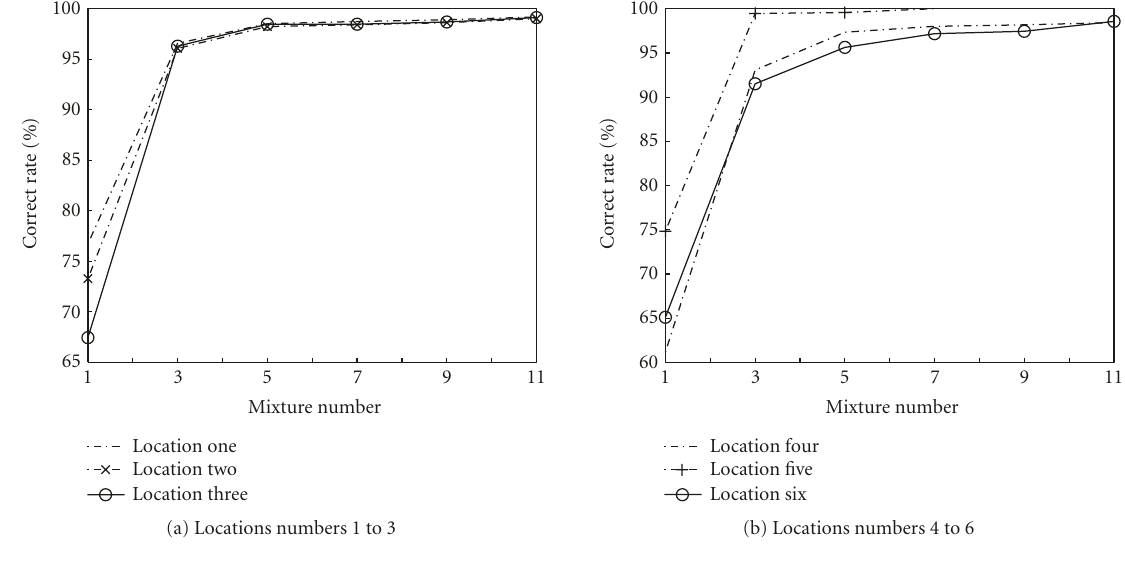
Figure 6: Average correct rates versus the mixture numbers. Table 4: Average error rates at various speeds under multiple speakers’ conditions.